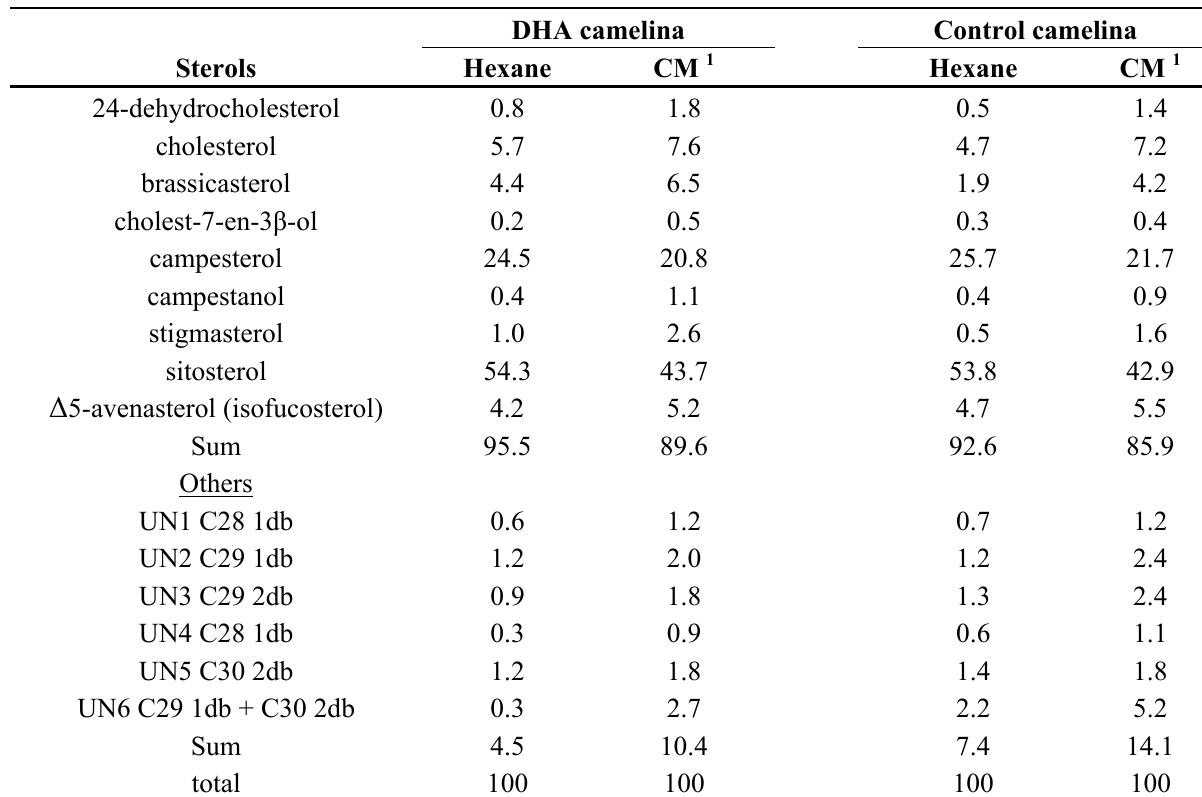
Table 5. Sterol composition (% of total sterols) of DHA- and control camelina. DHA